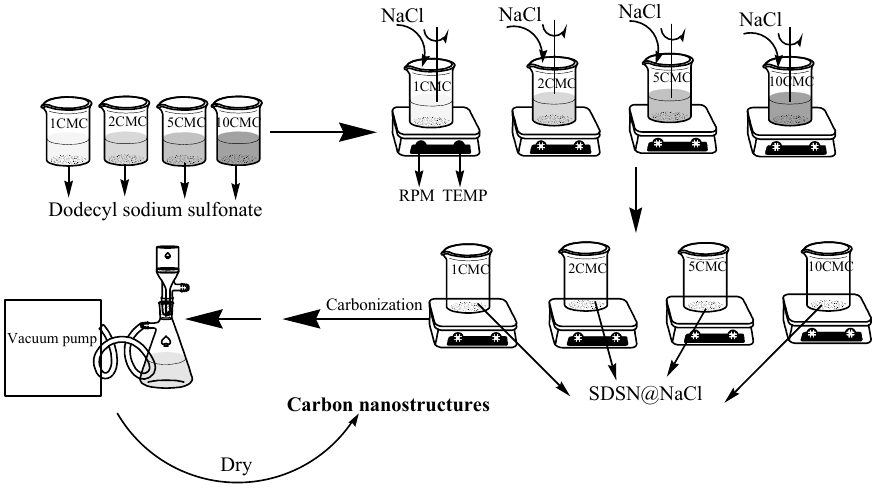
Figure 2. Experimental process diagram.